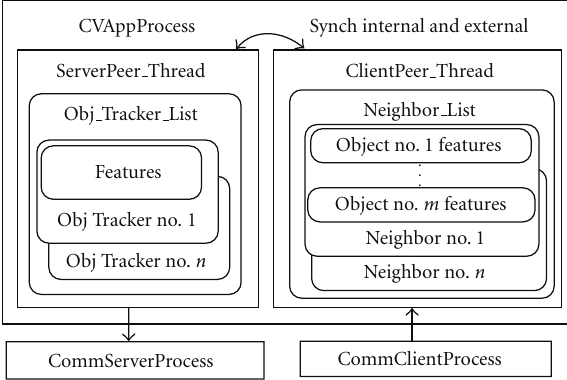
Figure 4: Computer vision processor internal architecture.